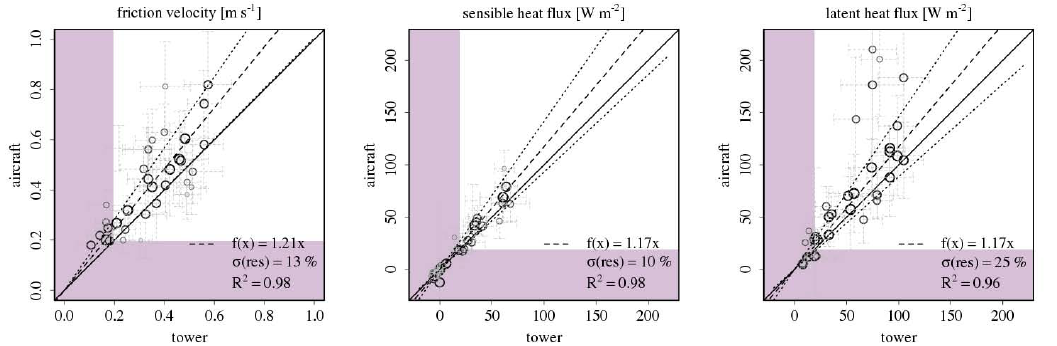
Fig. 6. Comparison between tower and WSMA eddy-covariance fluxes: friction velocity, sensible heat and latent heat. The results are displayed in the same way as Fig. 2. The data points in the shaded areas close to zero are omitted in the calculation of the normalized random errors (see Appendix A). Additional information is given in the text.